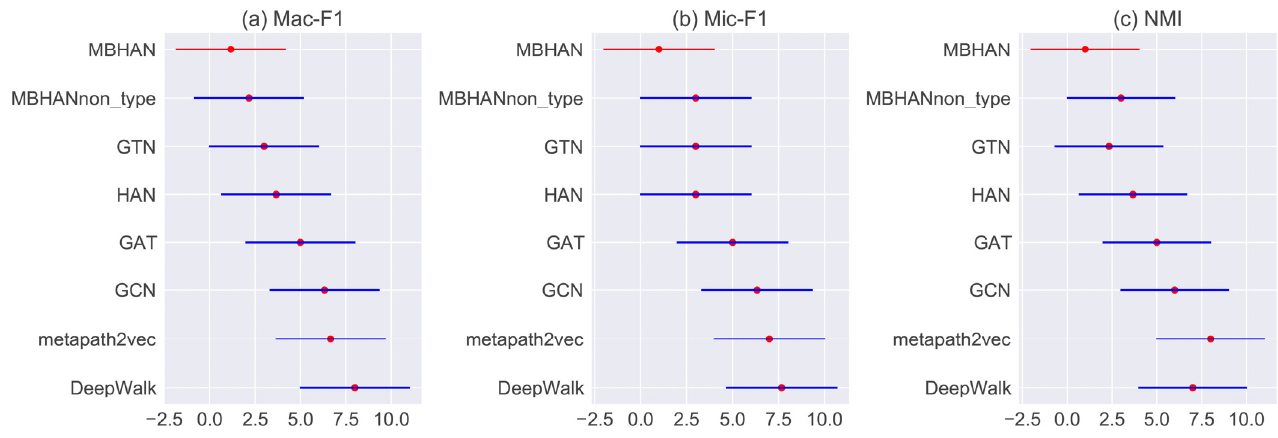
Figure 4. Average rank results of Nemenyi test.